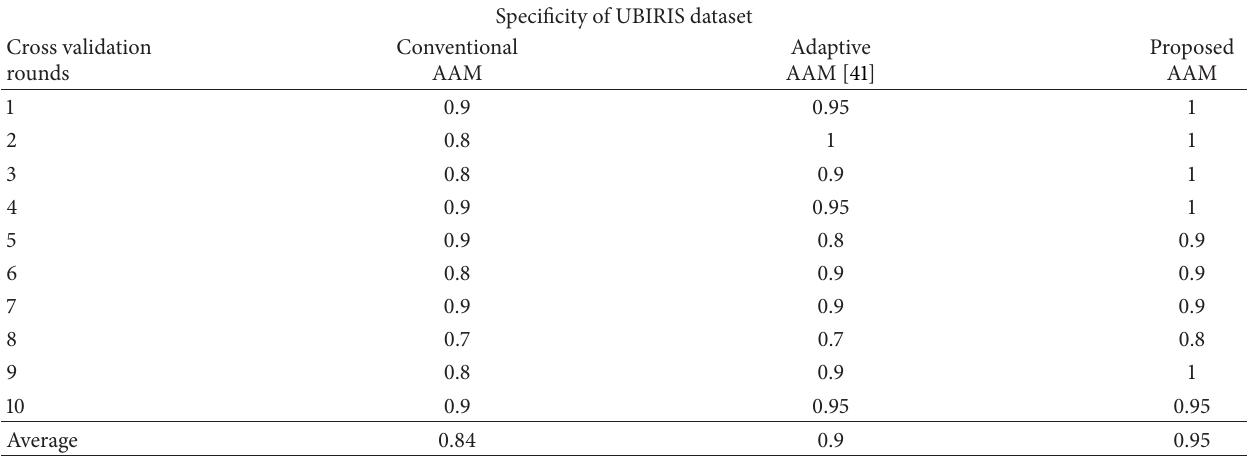
Table 11: Cross validation results for UBIRIS in terms of specificity for conventional AAM, adaptive AAM, and the proposed AAM.